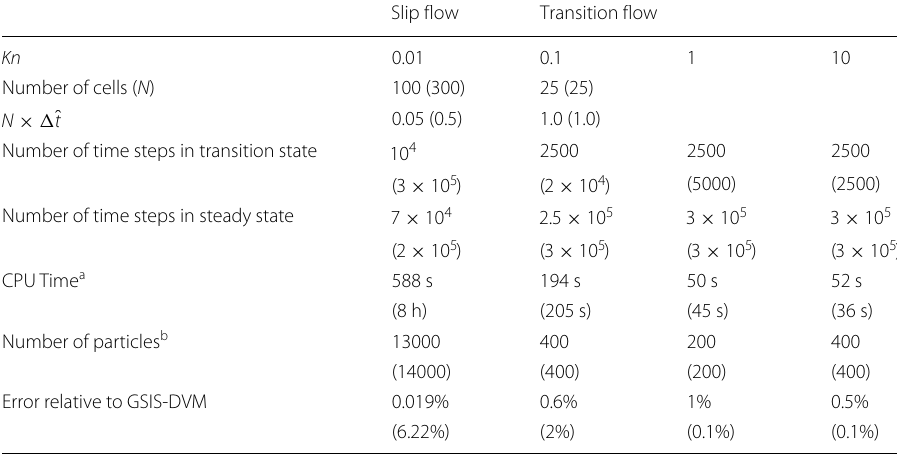
Table 1 Simulation parameters in the GSIS-LVDSMC and LVDSMC (values in parentheses) used in the 1D Poiseuille